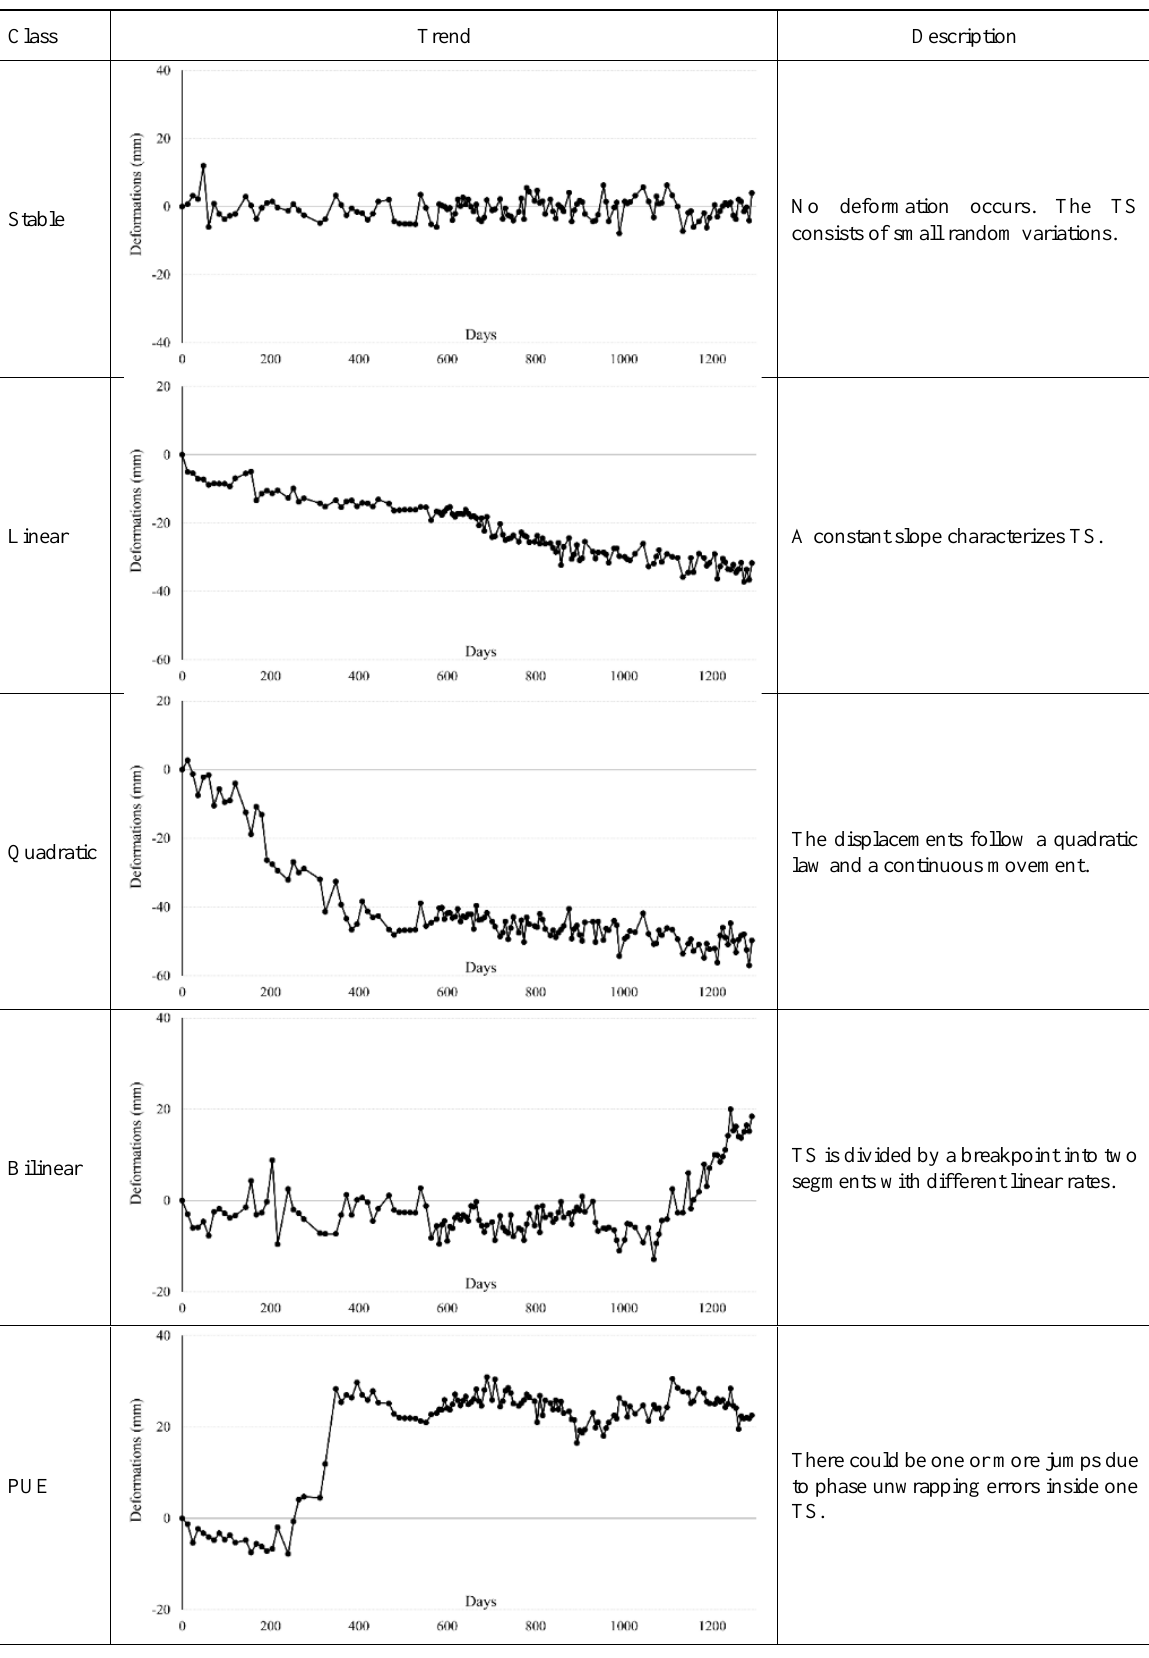
Table 1 . Descriptions and visual examples of five deformation classes based on definitions provided by (Berti et al., 2013; Mirmazloumi et al.,